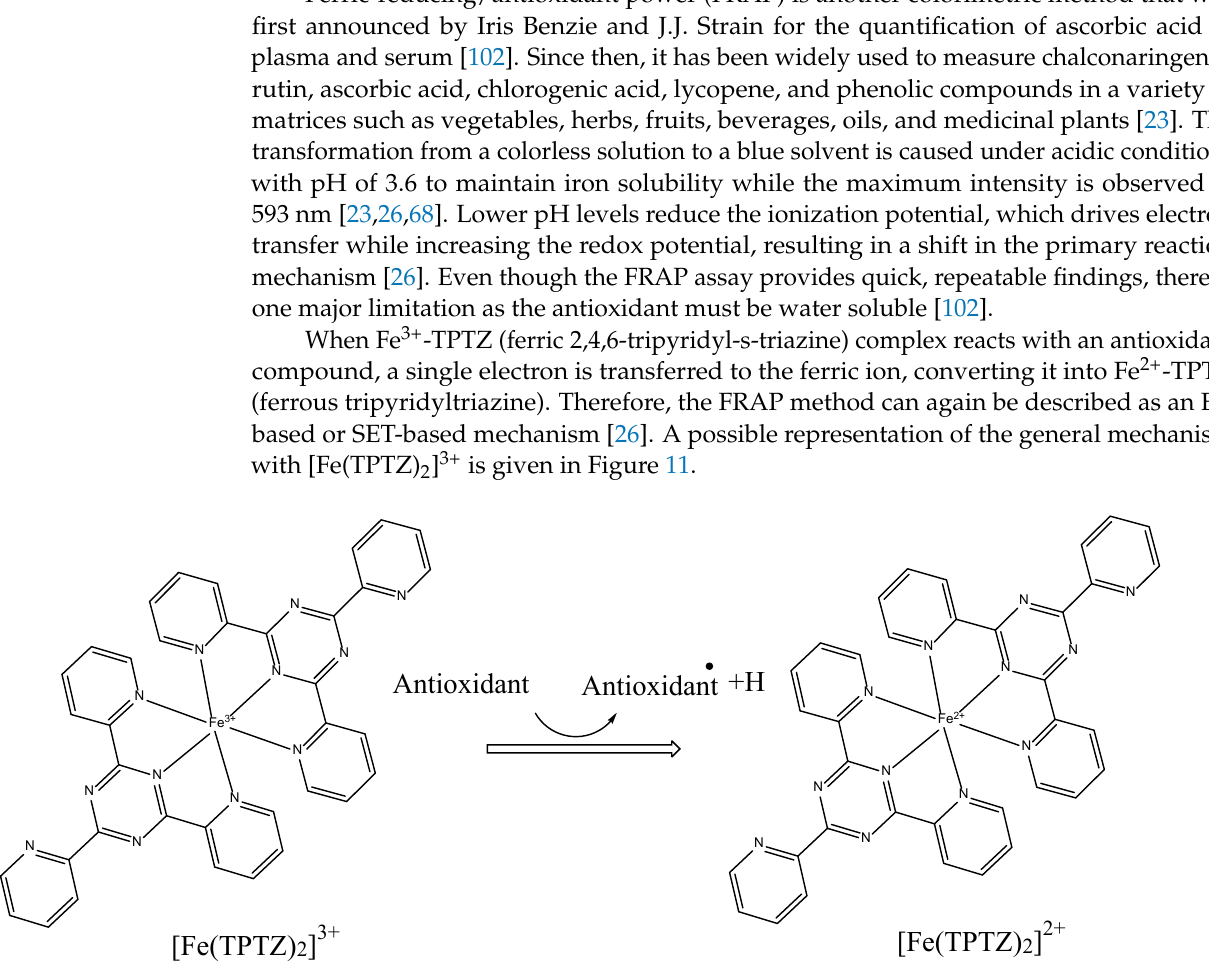
Figure 11. FRAP reductive mechanism by antioxidant species [26].